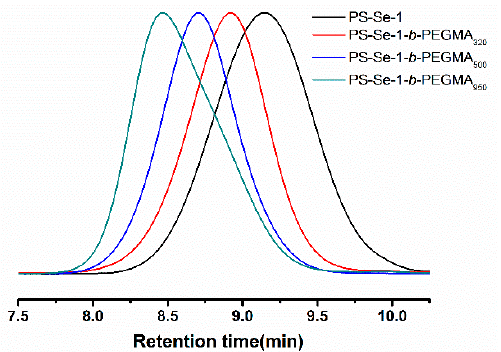
Figure 3. SEC curves of PS-Se-1 ( M n,SEC = 1900 g mol − 1 , Ð = 1.14), PS-Se-1- b -PEGMA 320 ( M n,SEC = 2700 g mol − 1 , Ð = 1.09), PS-Se-1- b -PEGMA 500 ( M n,SEC = 3200 g mol − 1 , Ð = 1.09), and PS-Se-1- b -PEGMA 950 ( M n,SEC = 3700 g mol − 1 , Ð = 1.11).